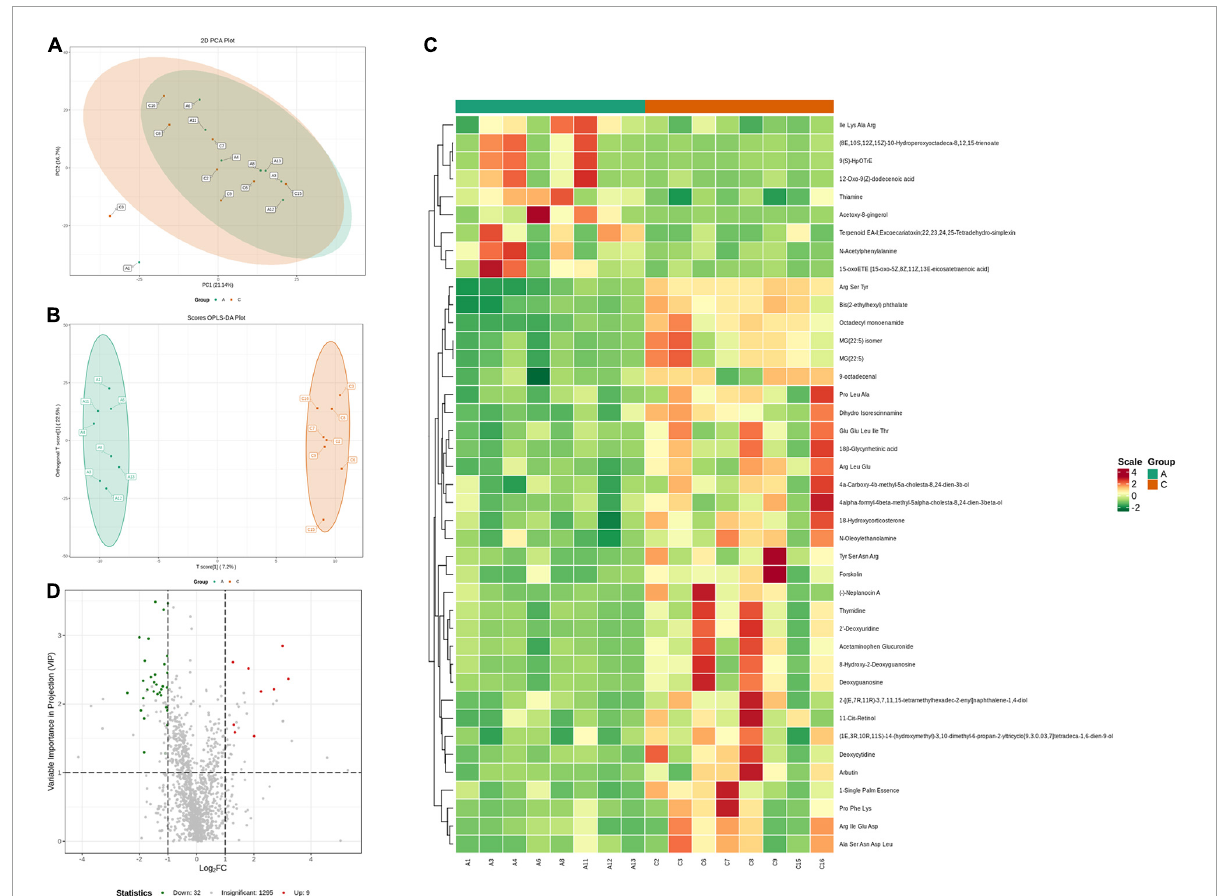
FIGURE5 Variation characteristics of fecal metabolites and screening for differential metabolites in APP/PS1 and wild-type mice. PCA plot (A) and score plot derived from the OPLS-DA model (B) . Heatmap (C) and volcano plots (D) of differential metabolites between the groups (red, upregulated in APP/PS1 mice; green, downregulated in APP/PS1 mice). Groups: A, APP/PS1 double-transgenic mice; C, wild-type control group of C57BL/6J mice; n =